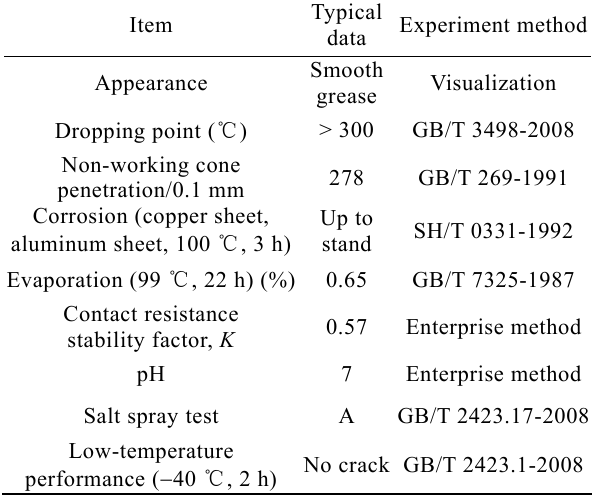
Table 2 Typical data of polyurea grease.